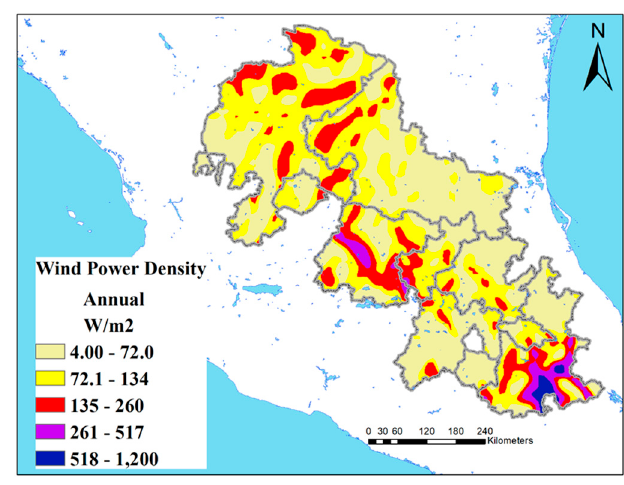
Figure 16. WPD in Central Mexico in ( a ) September, ( b ) October, ( c ) November and ( d ) December. Figure 17 shows the annual WPD map for the central region of Mexico.